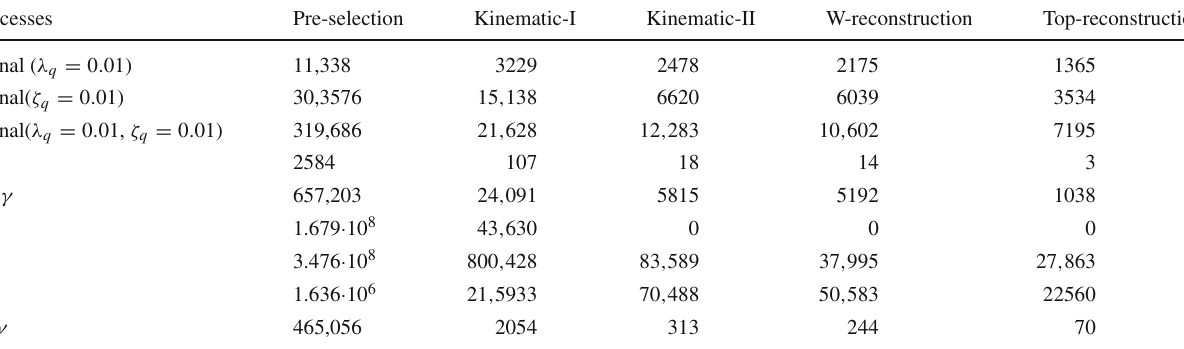
Table 4 The number of signal and relevant background events after each kinematic cuts in the analysis full hadronic mode with L int = 100 fb − 1 Processes Signal ( λ q = 0 . 01) Signal ( ζ q = 0 . 01) Signal ( λ q = 0 . 03, ζ q = 0 .